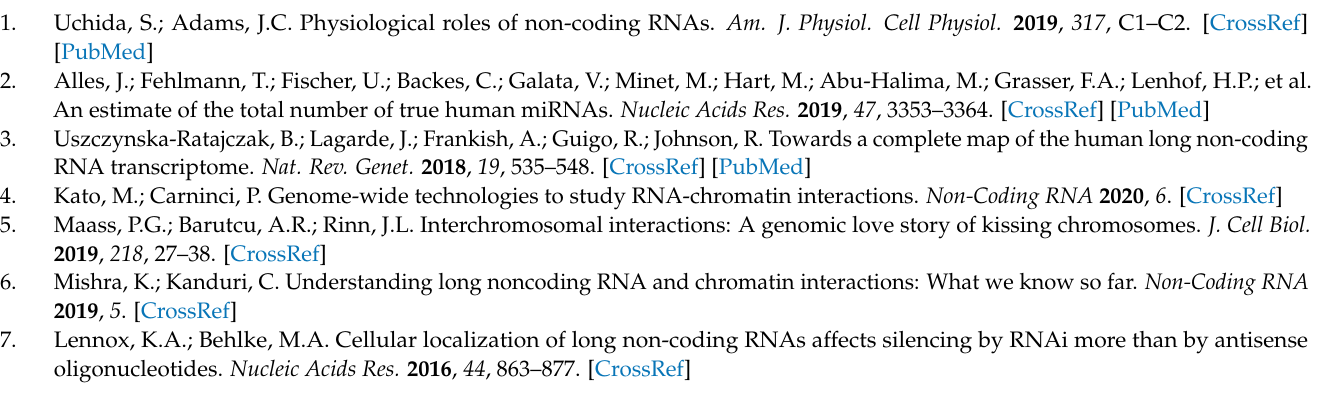
Supplementary Table S3: List of expressed RBPs and their binding to the up-regulated lncRNAs. Each number indicates the number of binding sites predicted to bound by each RBP